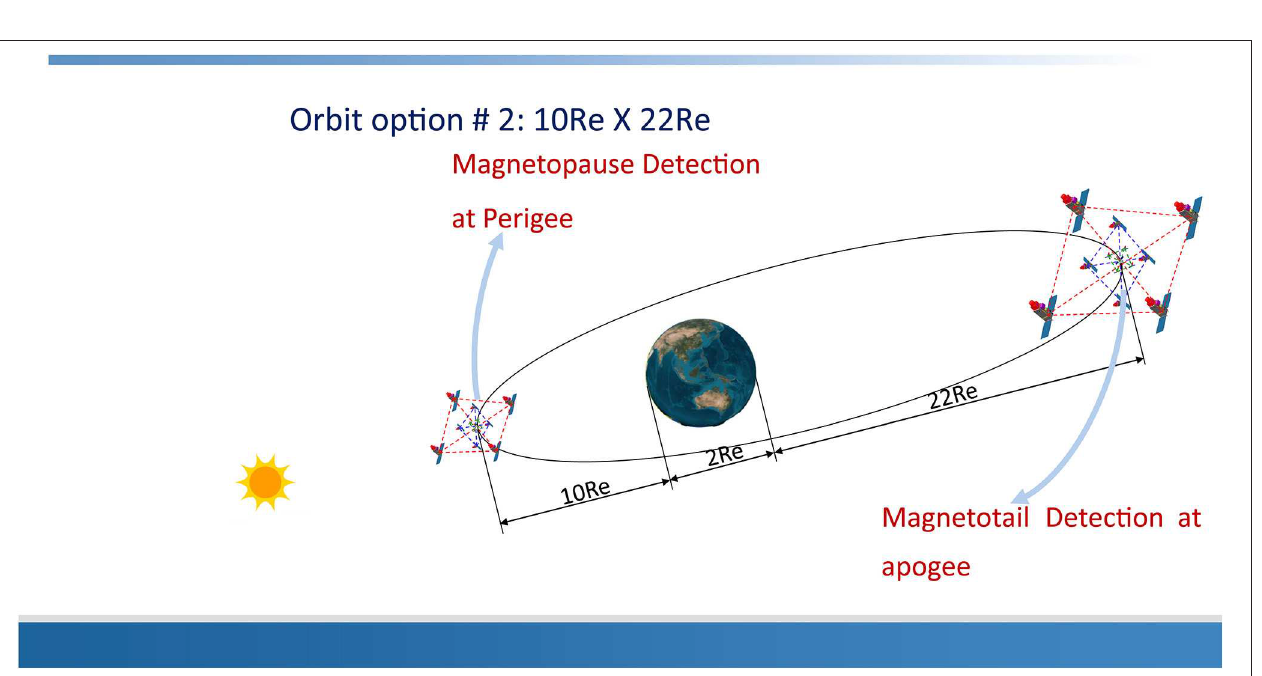
FIGURE 11 | The configuration of the spacecraft orbit in option # 2.